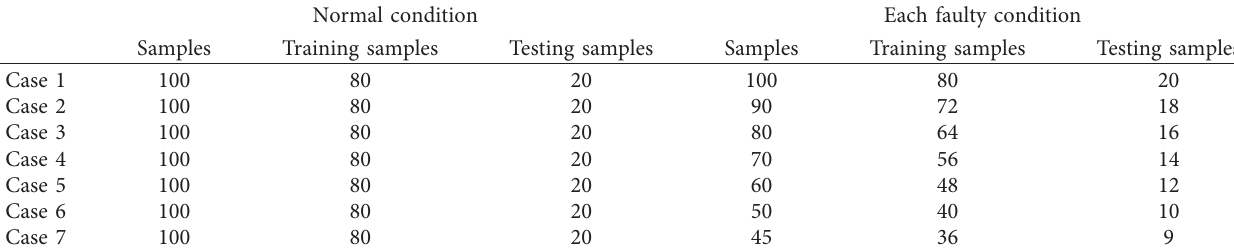
Table 2: Seven scenarios.